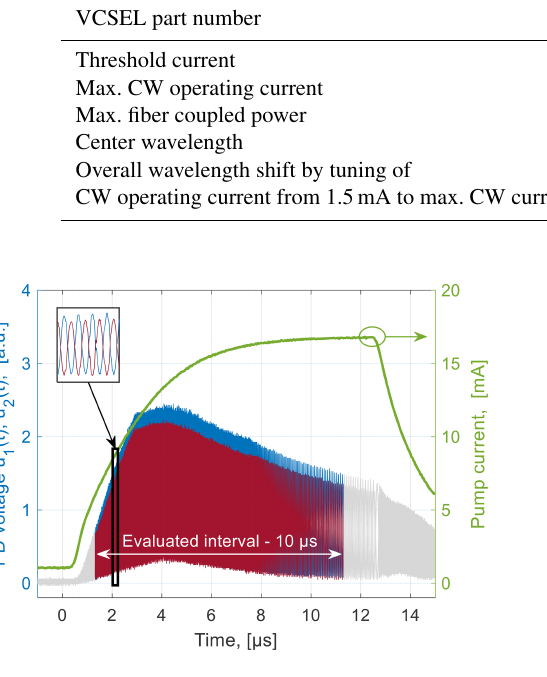
Figure 3. Typical waveforms for VL-1544 captured by photodetec- tors PD1 (blue) and PD2 (red) and the corresponding pump current pulse (green) with a pulse width of 12µs and a repetition rate of 50Hz ( i B = 1 and i P =